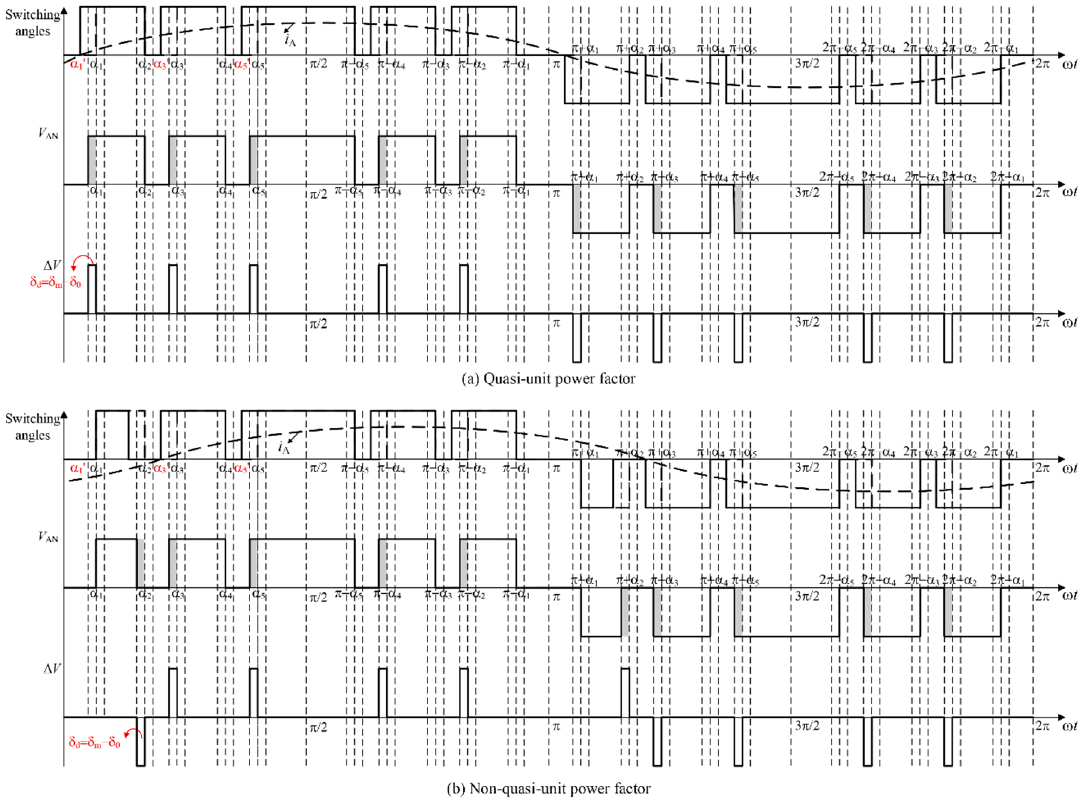
Figure 16. Output voltage error when over-compensation occurs ( δ m > δ 0 ) at quasi-unit power factor ( a ), and non-quasi-unit power factor ( b ).